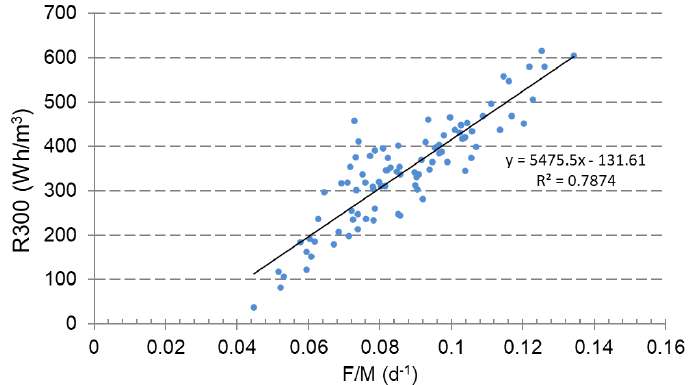
Figure 11. The reference values for R 300 vs. F/M ratio in WWTP K (θ c within 16 – 18 days). By analyzing the aeration energy index throughout the 1.8-year WWTP operation, the performance varies between good and excellent (Figure 12a), associated with energy consumption varying from 164 Wh/m 3 in the winter months to 560 Wh/m 3 in the summer months. Nevertheless, it may be further improved during the summer, when the deten- tion time increases due to lower influent flowrates (low season, Figure 12a) and the reactor is being over-aerated. The gains from better adjusting the energy consumed to the energy required, i.e., levering all days to energy PX 300, translate into a potential energy savings of, on average, 141 Wh/m 3 . Yu el al. [54], using Bayesian semi-parametric quantile regres- sion, identified the temperature and the total nitrogen-rich wastewater as the factors as- sociated with the higher level of energy consumption.